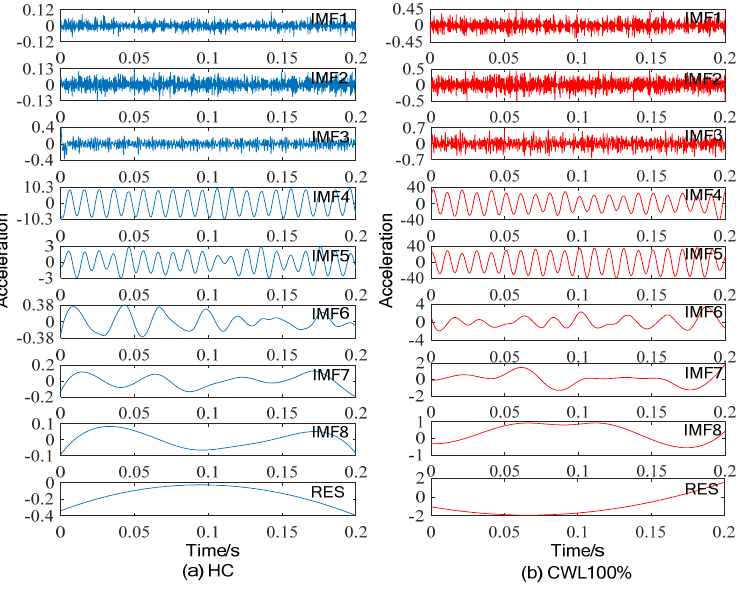
Figure 18. MCPCEEMD calculation results for HC and CWL100%.